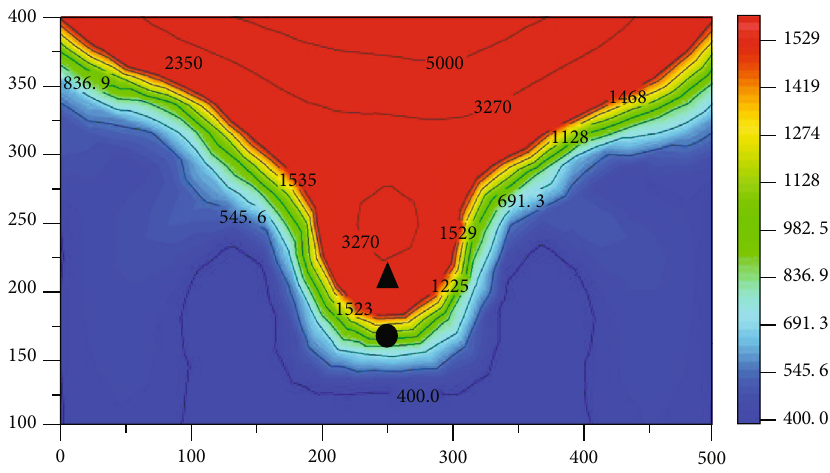
Figure 15: Pressure distribution at the end of the experiment (300 ° C, kPa).